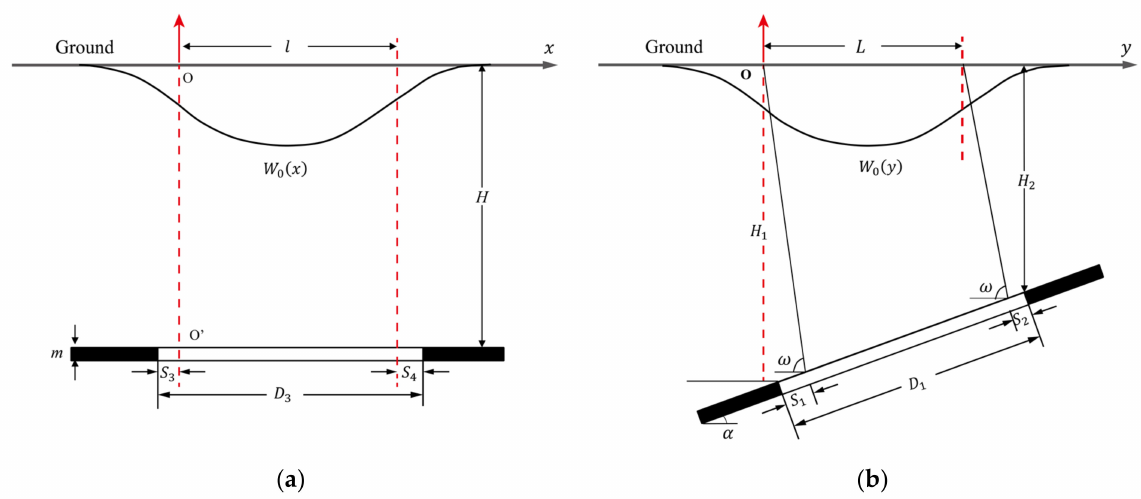
Figure 2. ( a ) Mining subsidence caused by finite extraction in the strike direction; ( b ) mining subsidence caused by finite extraction in the dip